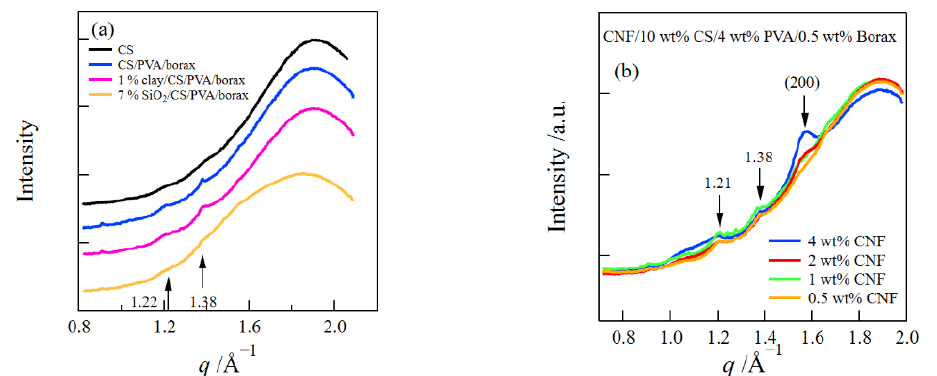
Figure 6. WAXS profiles of 10 wt% CS aqueous solution and CS/PVA/borax, 1 wt% clay/CS/PVA/borax, and 7 wt% SiO 2 /CS/PVA/borax composite hydrogels ( a ), and WAXS profiles of CNF/CS/PVA/borax composite hydrogels at different CNF concentrations ( b ).